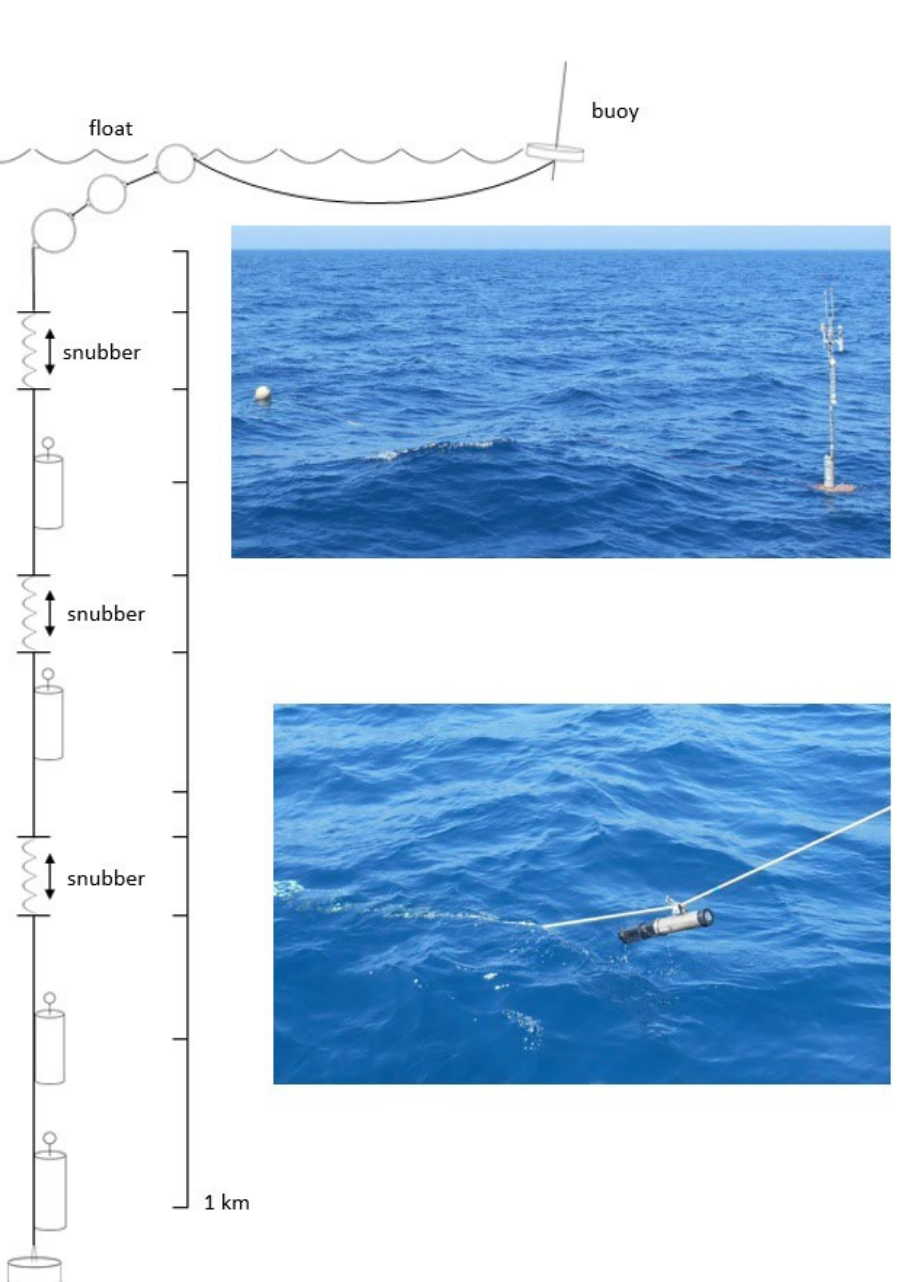
Figure 10. Scheme of setting up a distributed receiving system.